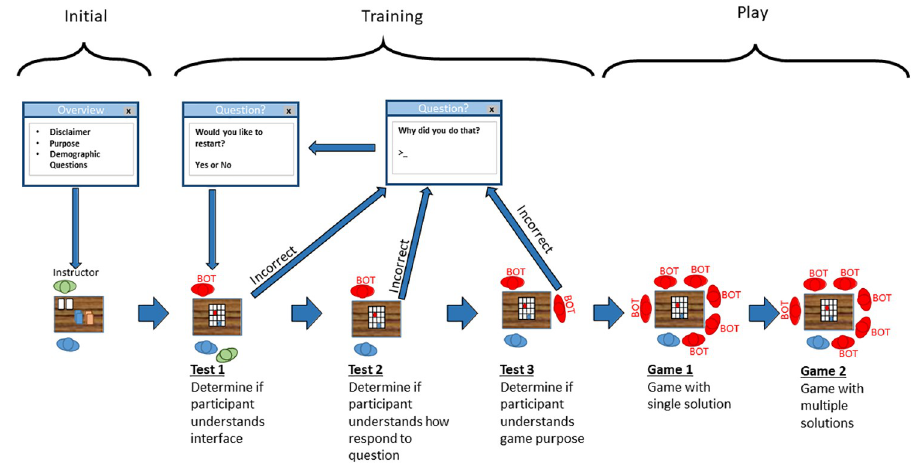
Fig 1. Flow diagram of the experimental trial adapted from Collins and Etemadidavan [14].